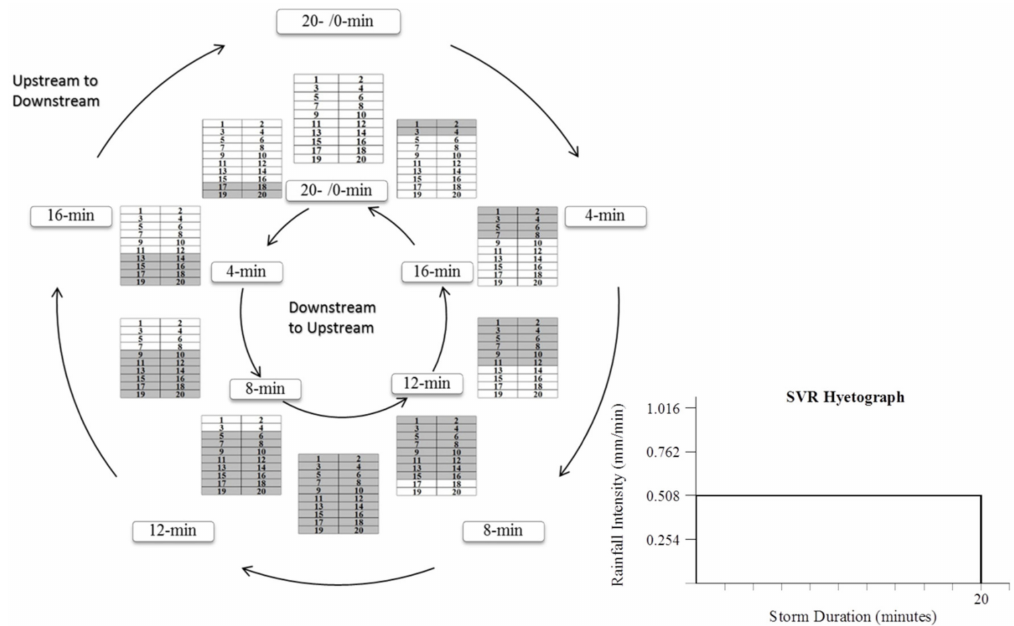
Figure 2. Spatially varied rainfall (SVR) applied to synthetic rectangular drainage